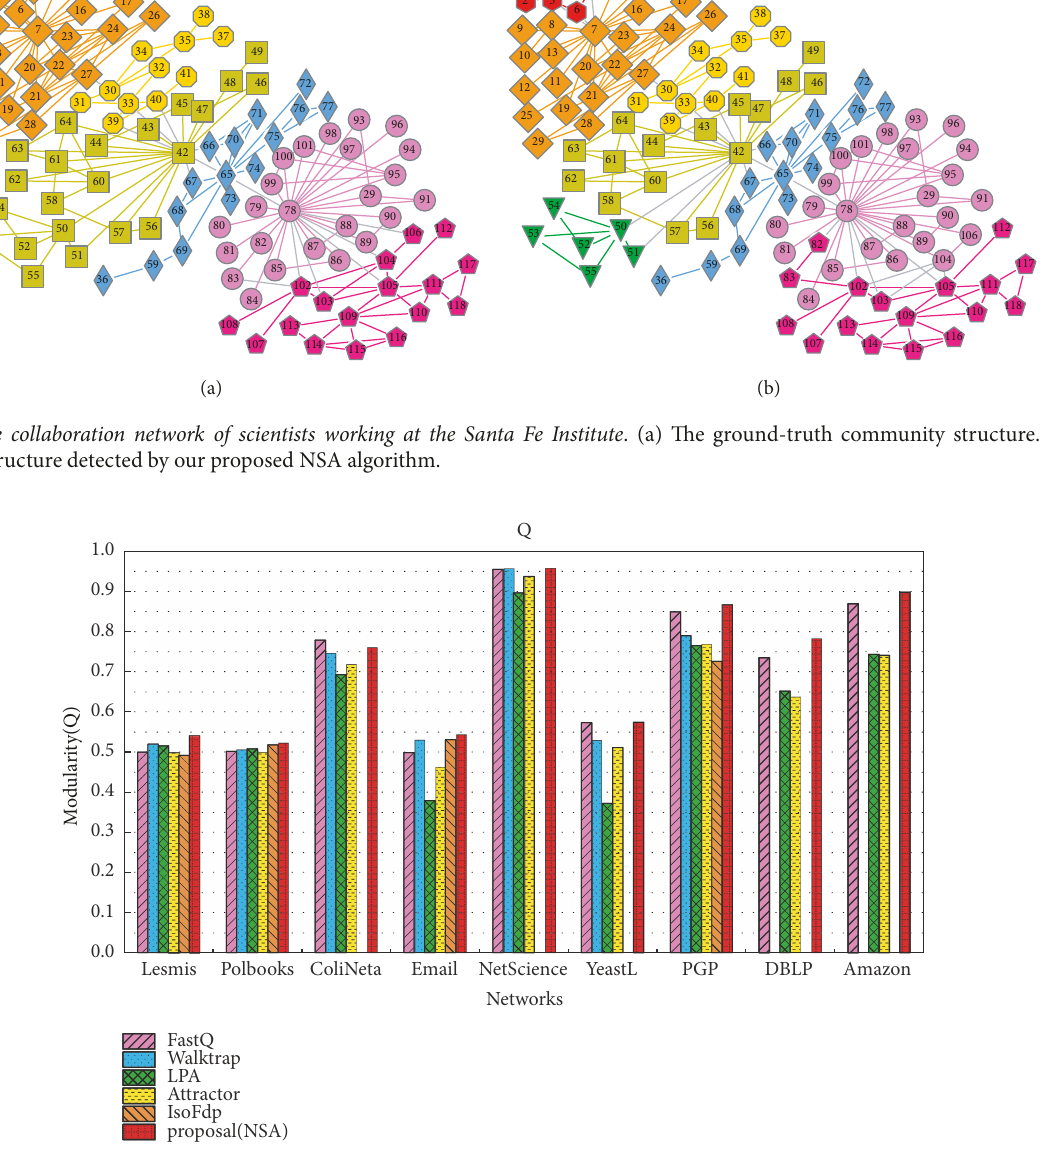
intuitively, we also plotted them in a bar chart, which is presented in Figure